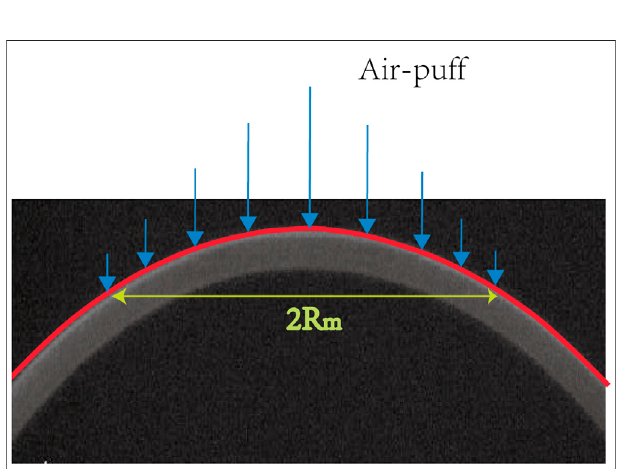
FIGURE 2 | Schematic of air-puff acts on the cornea during the Corvis ST